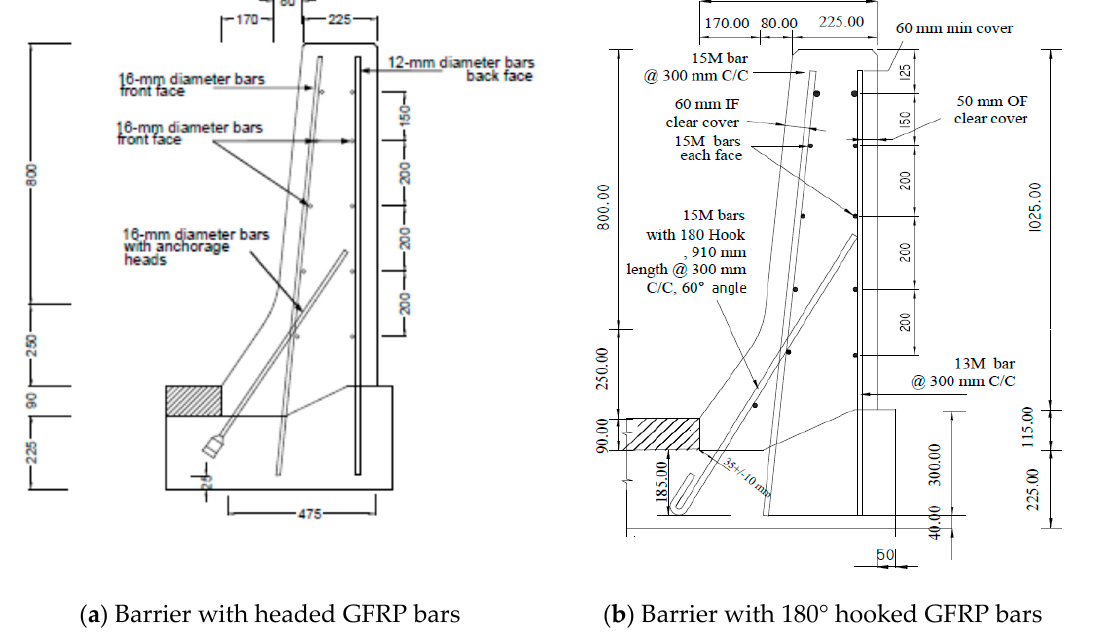
Figure 1. Reinforcement details of AASHTO test level 5 (TL-5) barrier reinforced with glass fiber reinforced polymer (GFRP) bars with headed ends and 180° hooks. ( a ) Barrier with headed GFRP bars; ( b ) Barrier with 180° hooked GFRP bars.